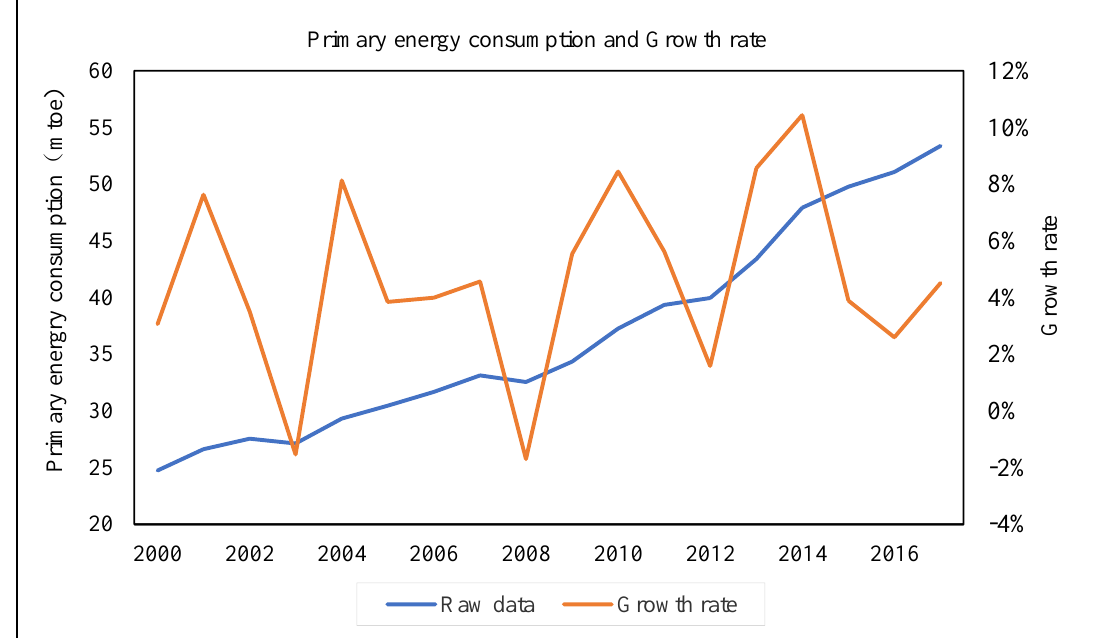
Figure 2. Primary energy consumption (Unit : mtoe) and growth rate in East Africa from 2000 to 2017.